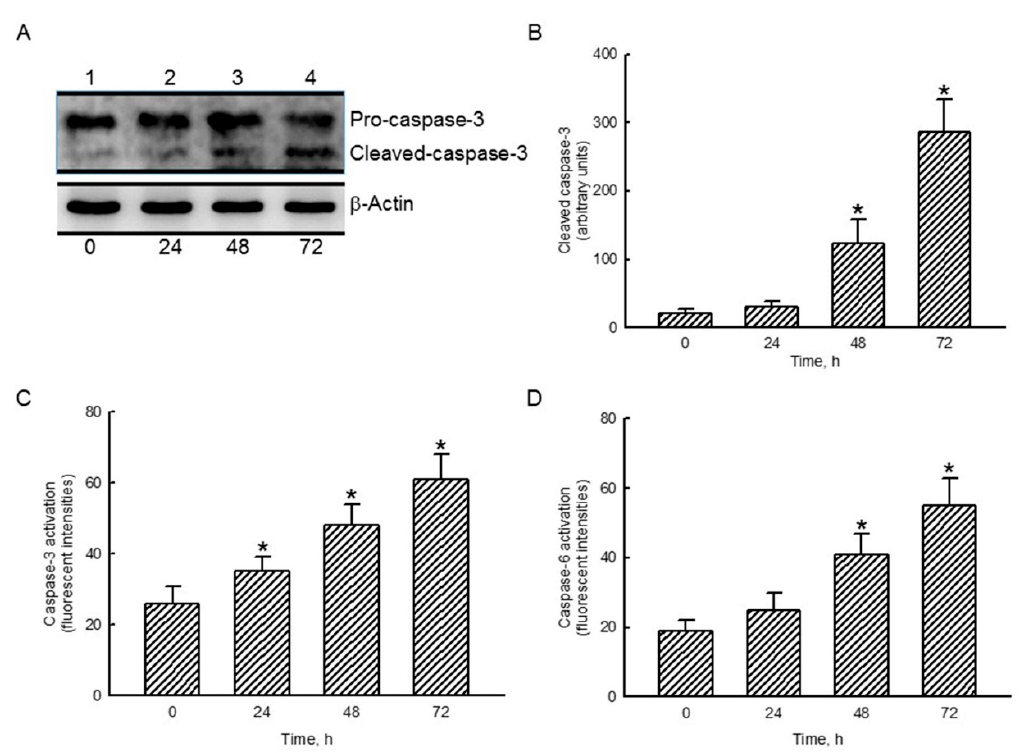
Figure 4. Honokiol induced sequential activation of caspase-3 and caspase-6 in human drug-resistant glioblastoma cells. Human TMZ-resistant U87-MG-R9 glioblastoma cells were exposed to 40 µ M honokiol for 24, 48, and 72 h. Levels of pro- and cleaved caspase-3 were immunodetected ( A , top panel). β -Actin was analyzed as an internal control (bottom panel). These protein bands were quantified and statistically analyzed ( B ). Activities of caspase-3 ( C ) and caspase-6 ( D ) were assayed using fluorogenic substrate methods. Each value represents the mean ± SD for at least three independent determinations. The symbol * indicates that the value significantly differs from the respective control, p < 0.05.